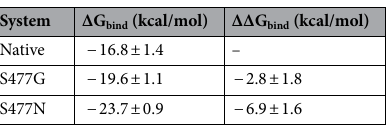
Table 1. Binding free energies for native and S477 variants with standard